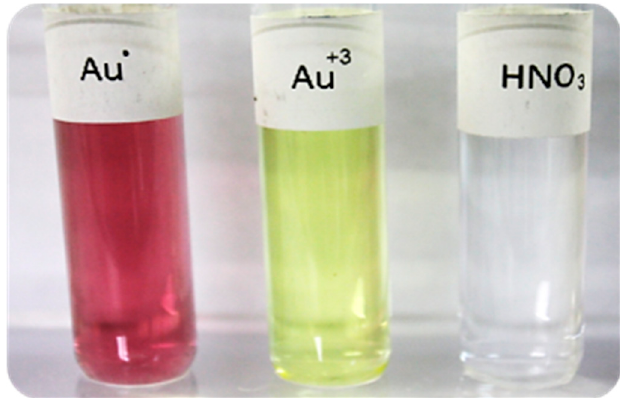
Figure 6. TGA thermogram of ( a ) CF-OH, ( b ) CF-SH, and ( c ) CF-SH-Hg.